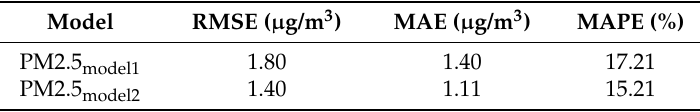
Table 2. Error metrics for the mobile run test (with lag correction).